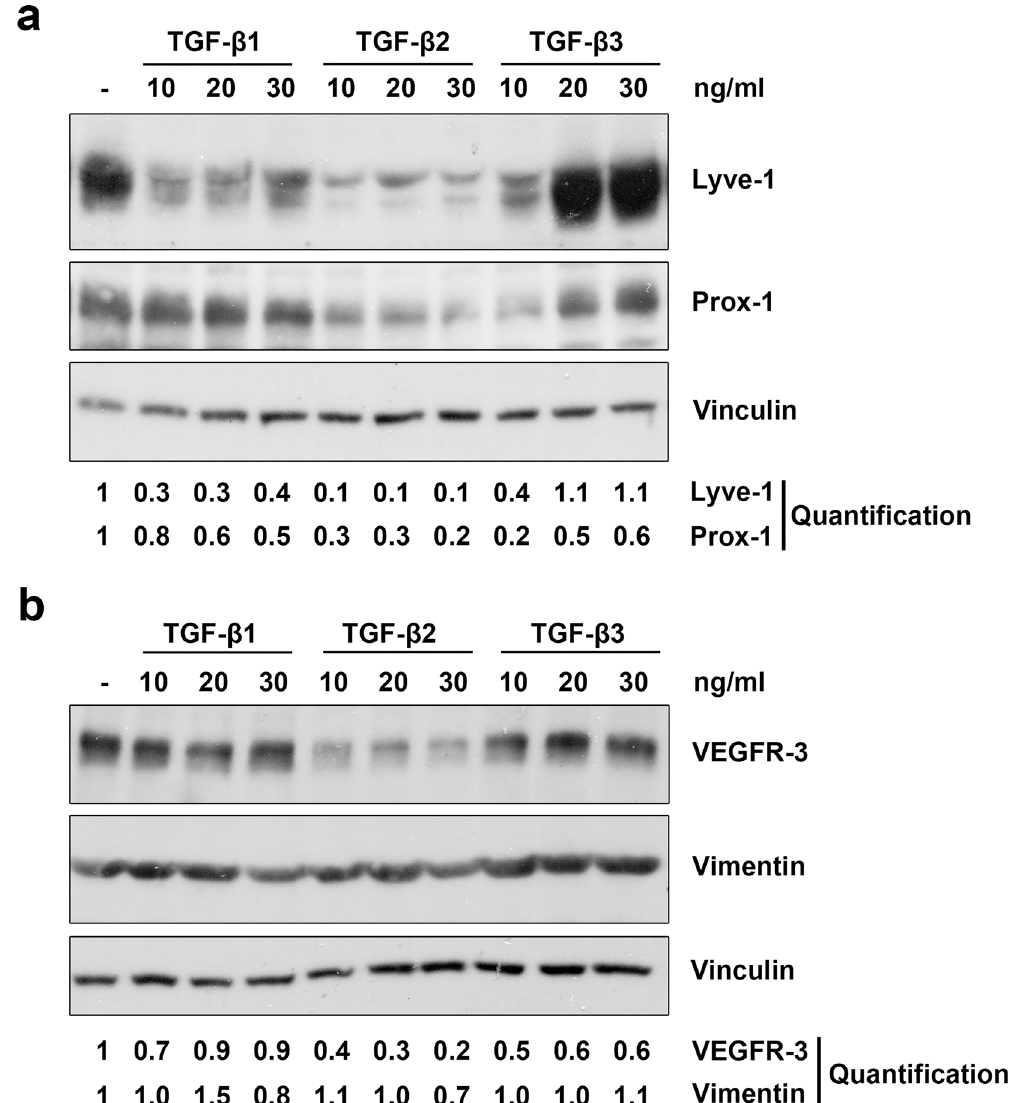
Fig 3. TGF- β 1, - β 2 and - β 3 reduce lymphatic marker expression in LECs. Primary human LECs were treated with 10, 20 or 30 ng/ml TGF- β 1, - β 2 and - β 3 for 72 hours ( a ) or 100 hours ( b ). Untreated cells served as a control. Lysates were prepared and analysed by Western blot using antibodies specific for Lyve-1, Prox-1, VEGFR-3 or vimentin. Vinculin served as loading control. The experiment was performed twice with equivalent results. For densitometry evaluation, protein bands were analysed using the software ImageJ. Bands for the Prox-1, Lyve-1, vimentin and VEGFR-3 proteins were normalized to the corresponding loading control and are displayed as the expression level relative to the untreated control